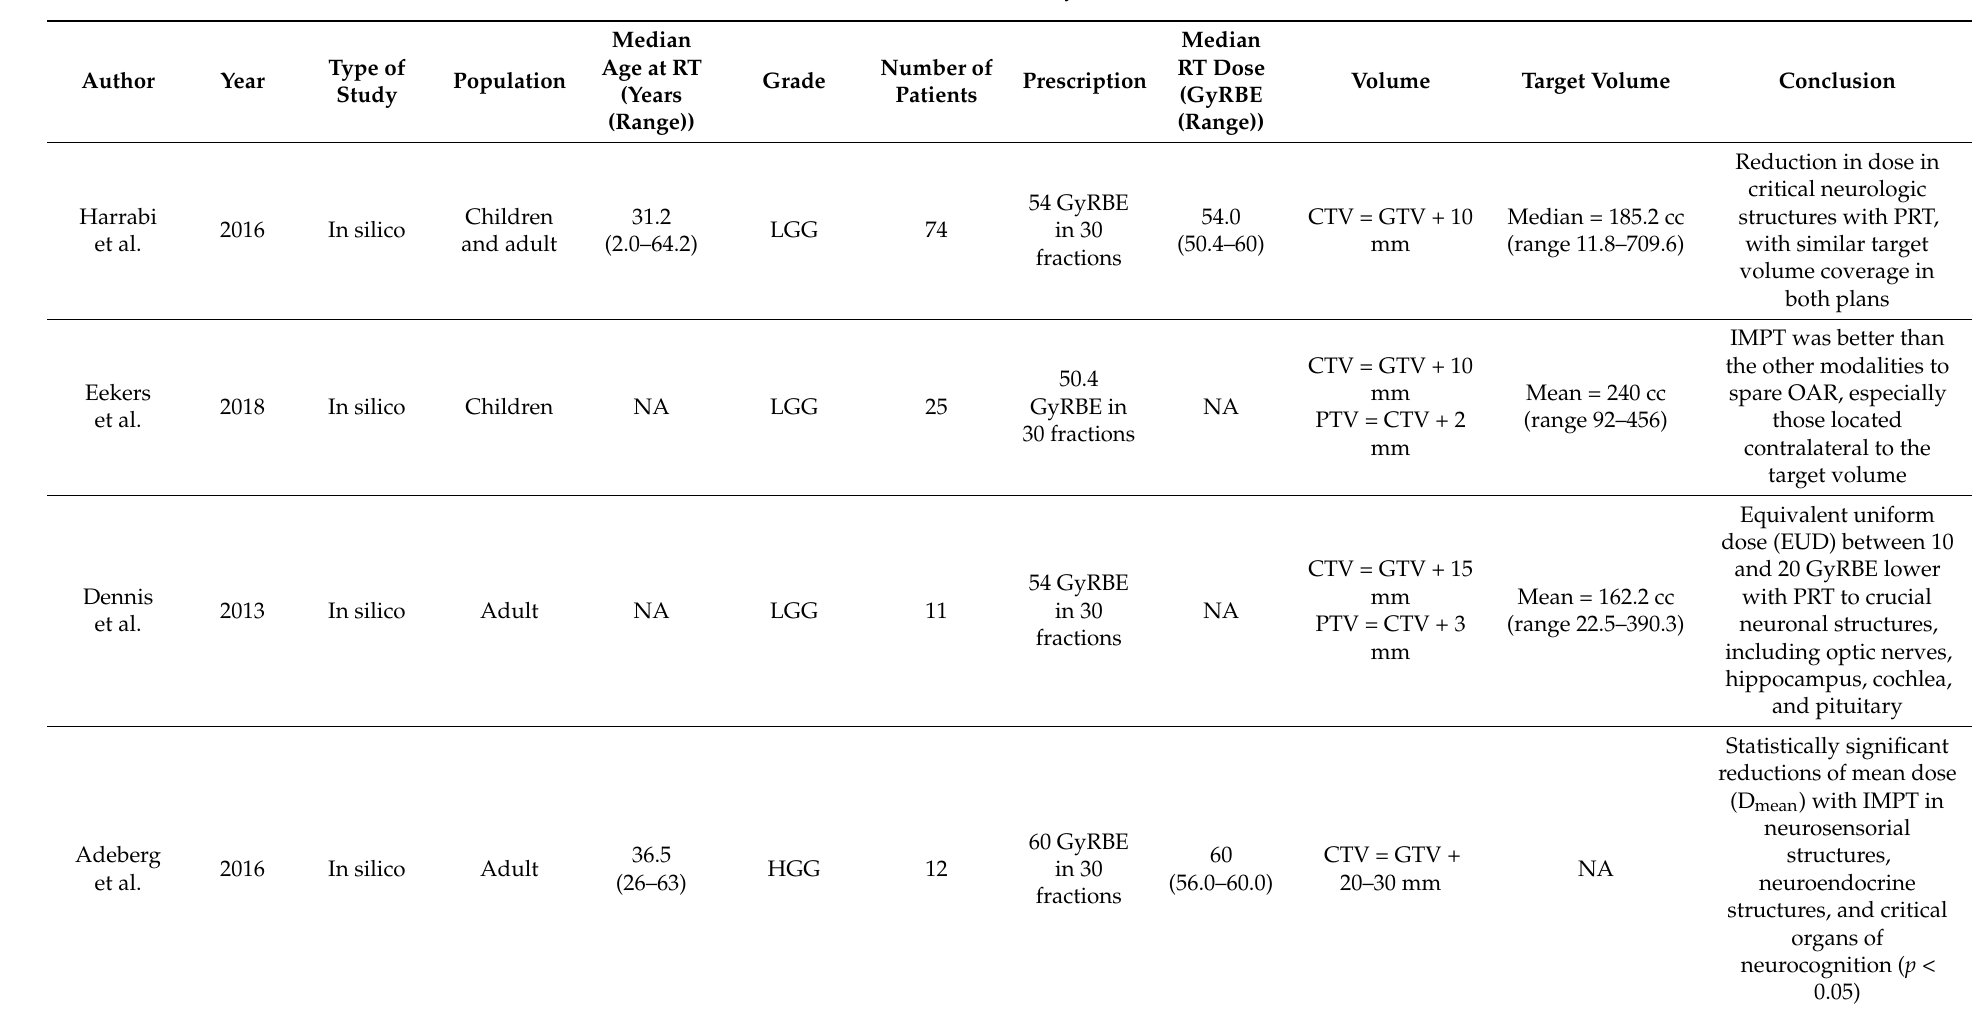
Table 3. Dosimetry